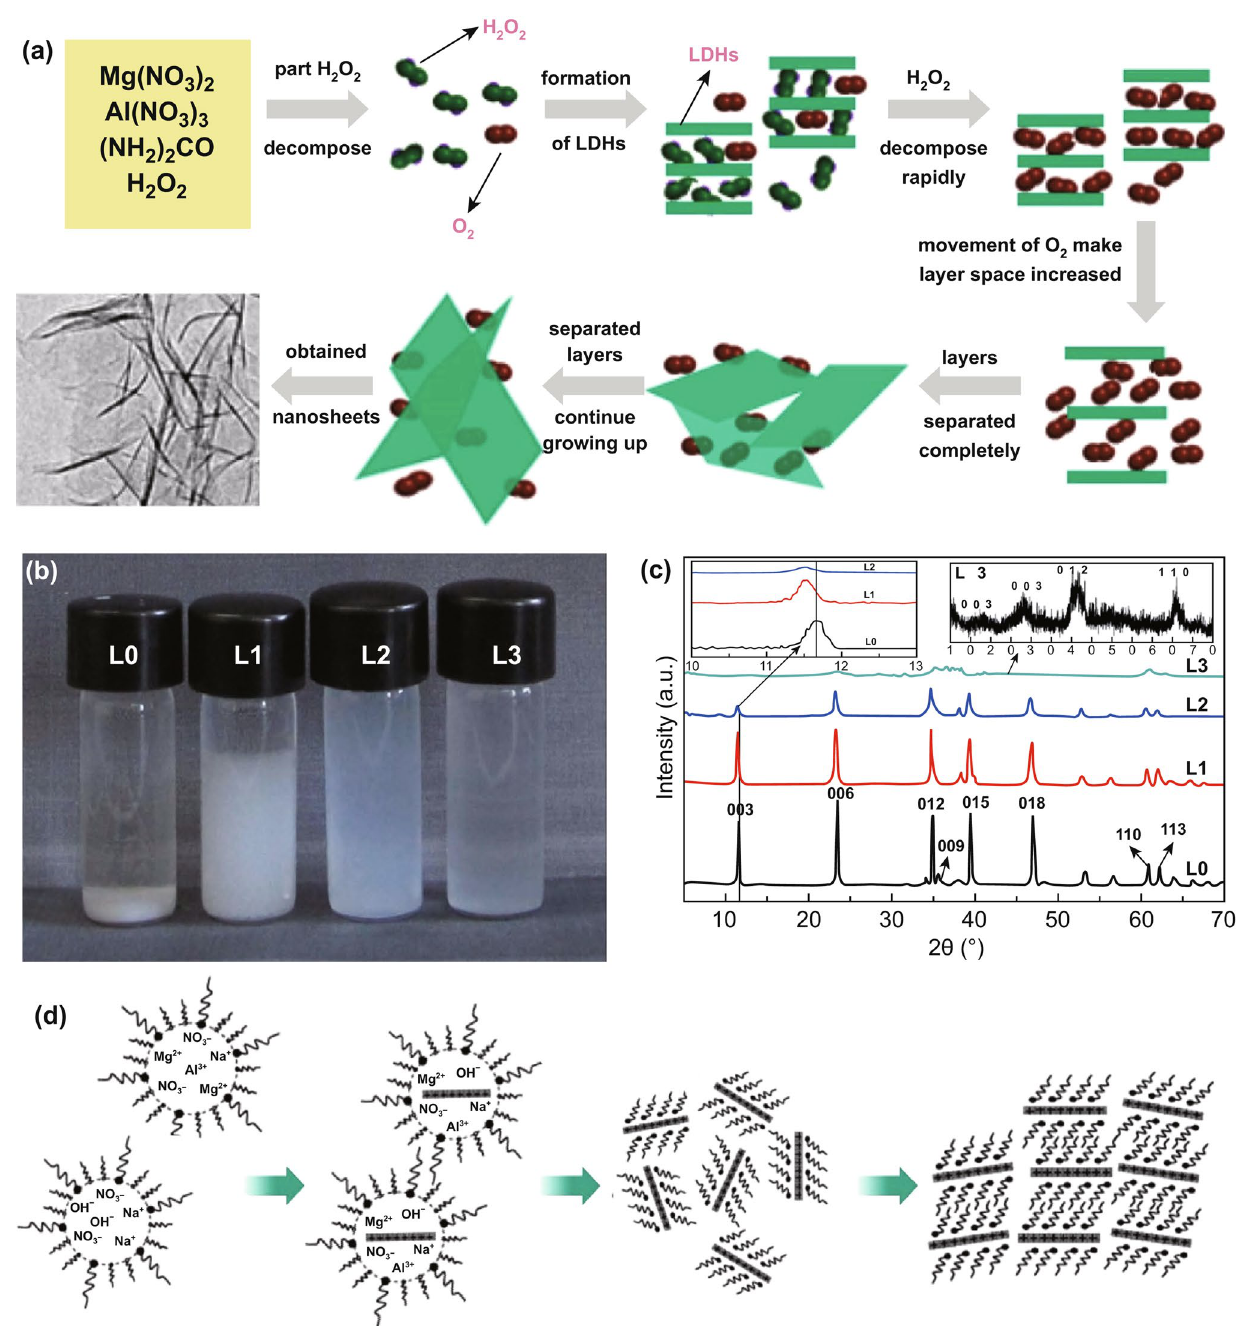
Fig. 4 a Suggested scheme for preparing exfoliated MgAl‑LDH nanosheets. b , c Digital graphs of MgAl‑LDHs suspension with different con‑ tents of H 2 O 2 and the corresponding XRD patterns. Reproduced with permission from Ref. [34]. Copyright 2012 Elsevier Inc. d Schematic illustration of the nucleation and growth of LDH platelets. Reproduced with permission from Ref. [35]. Copyright 2006 The Royal Society of